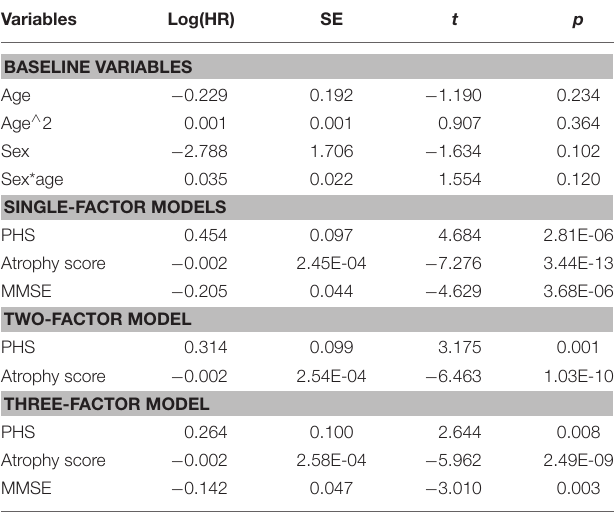
TABLE 2 | Results from Cox model analyses.